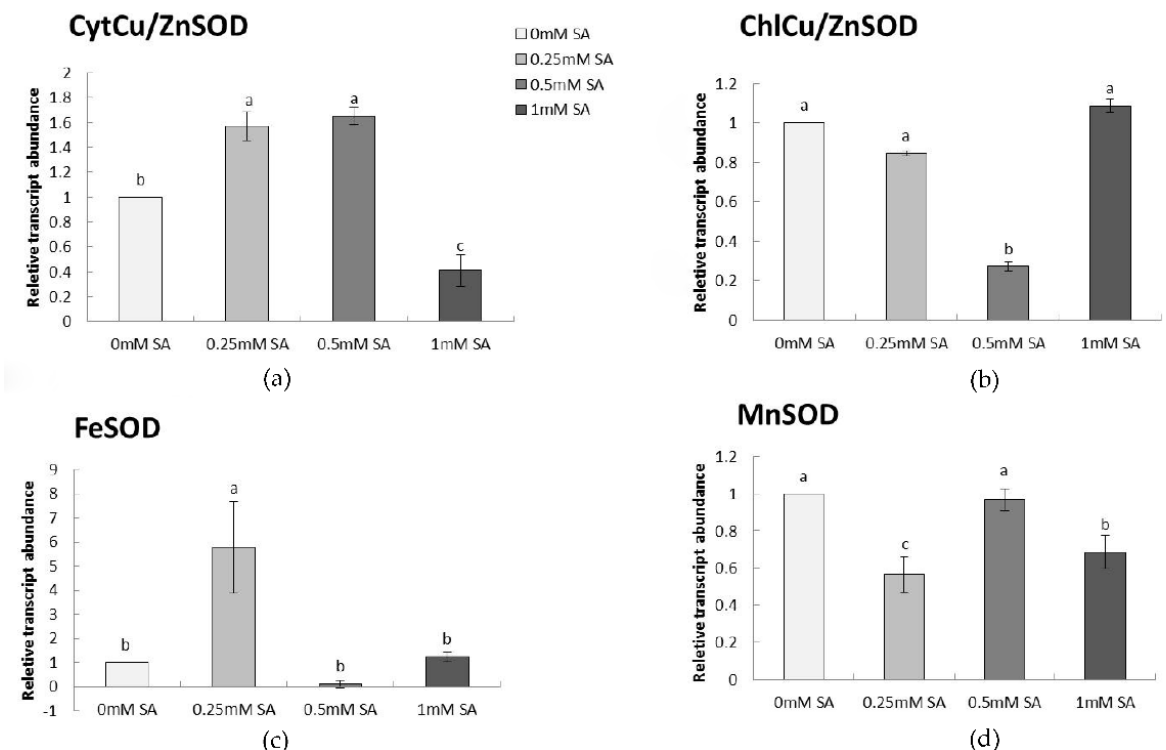
Figure 3 . Effect of SA treatment on the relative abundance of CytCu/ZnSOD ( a ), ChlCu/ZnSOD ( b ), FeSOD ( c ) and MnSOD ( d ) transcripts determined through RT-qPCR in perennial ryegrass under 250 mM NaCl stress. The values are the means ± SD ( n = 4). The different letters indicate significant differences between various SA treatments ( p ≤ 0.05).